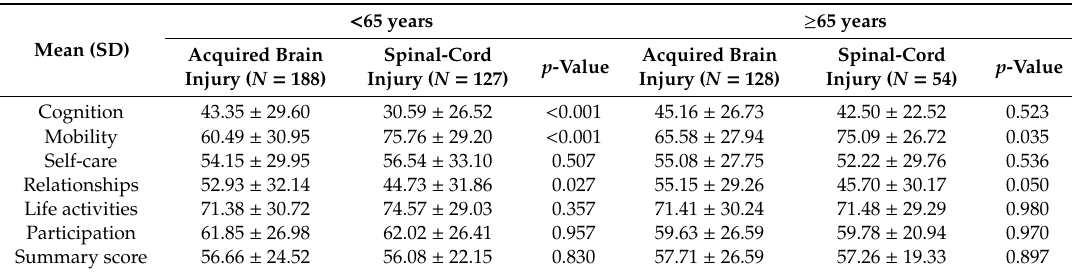
Table 3. Comparison of WHODAS 2.0 scores of overall disability across domains between participants with brain and spinal-cord injuries according to age.